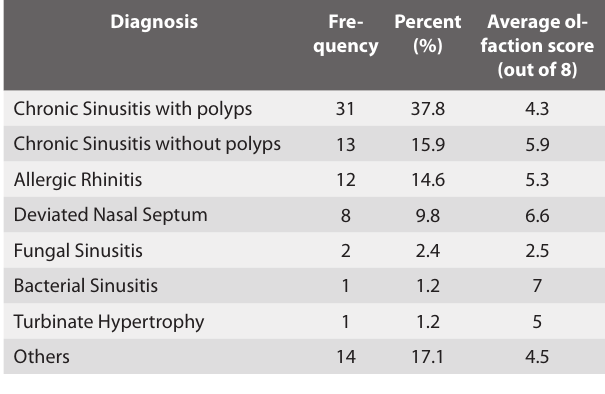
Table 1. Primary diagnosis of patients in the patient group in descending order, with number and percentage of patients in each pathology, and their respective average score for each